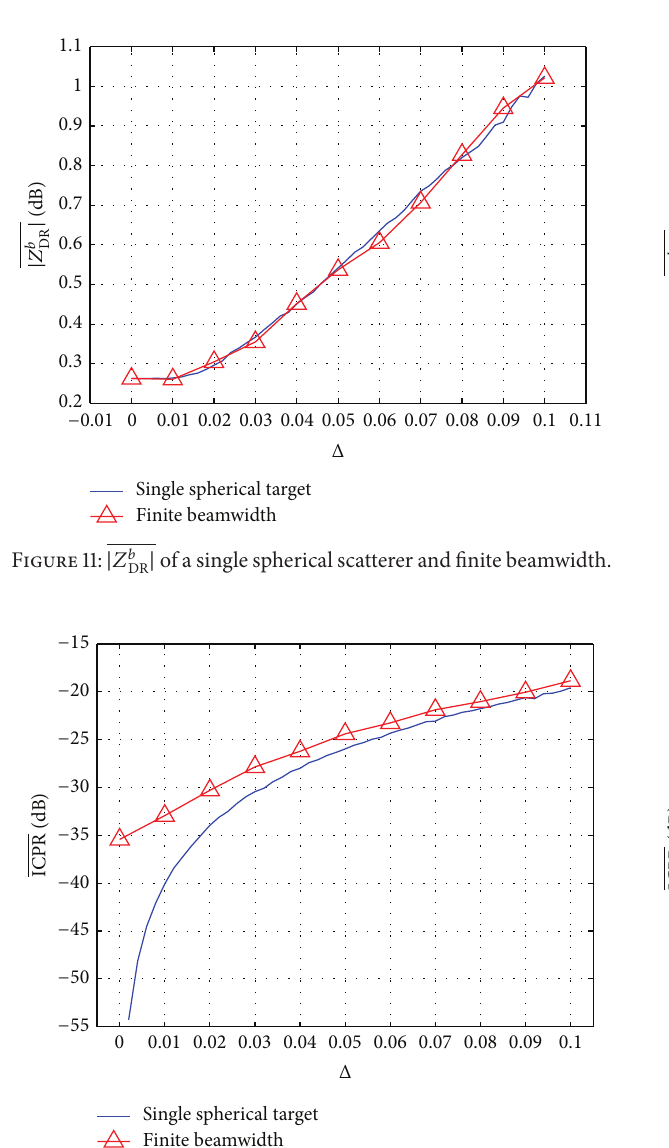
Figure 14: The impact of the channel coupling on